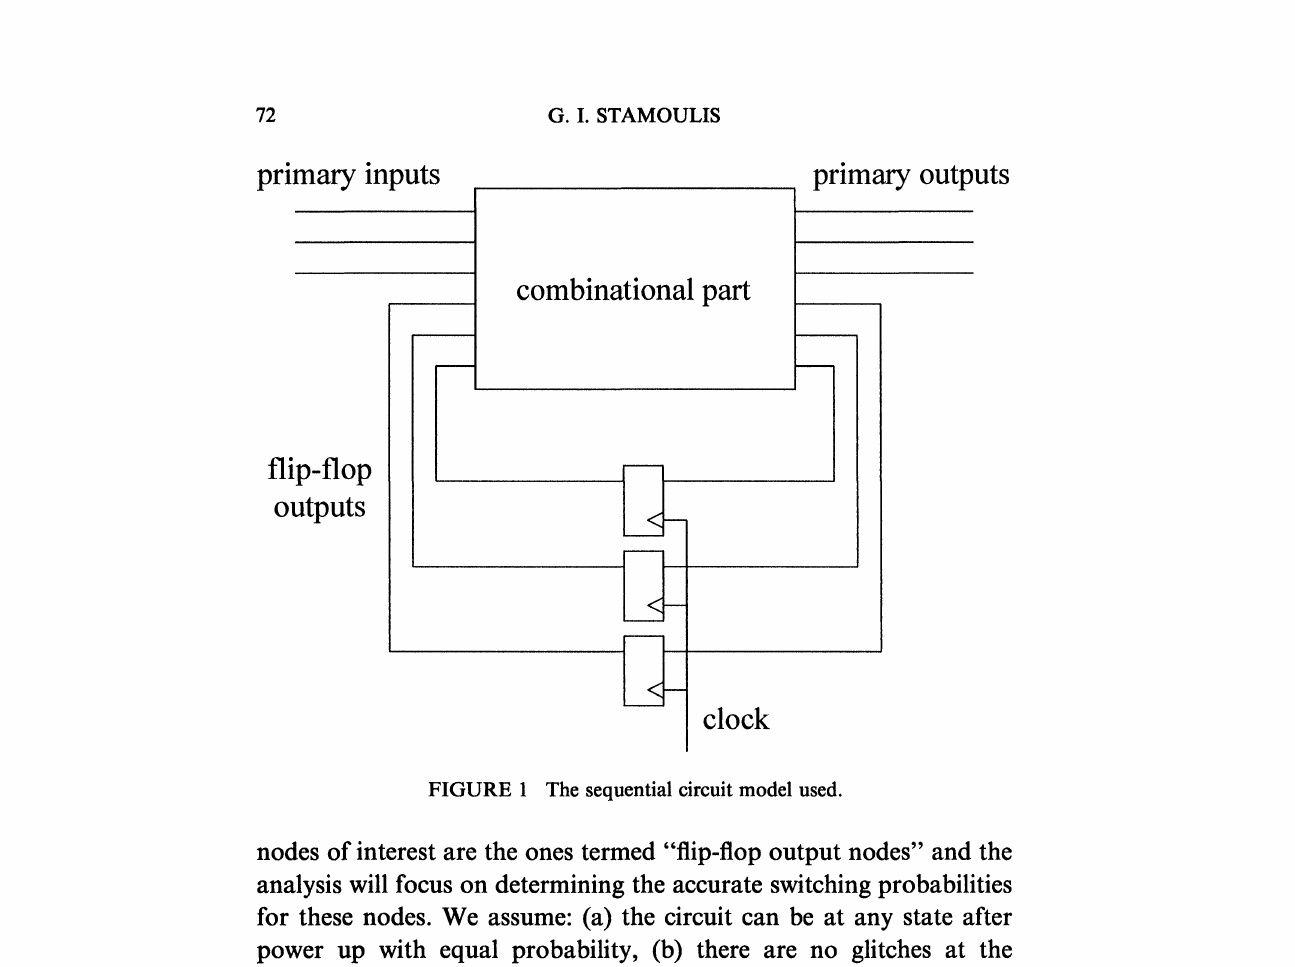
FIGURE The sequential circuit model